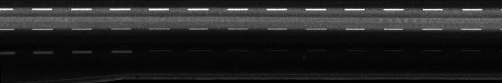
Figure 9. Road surface point clouds